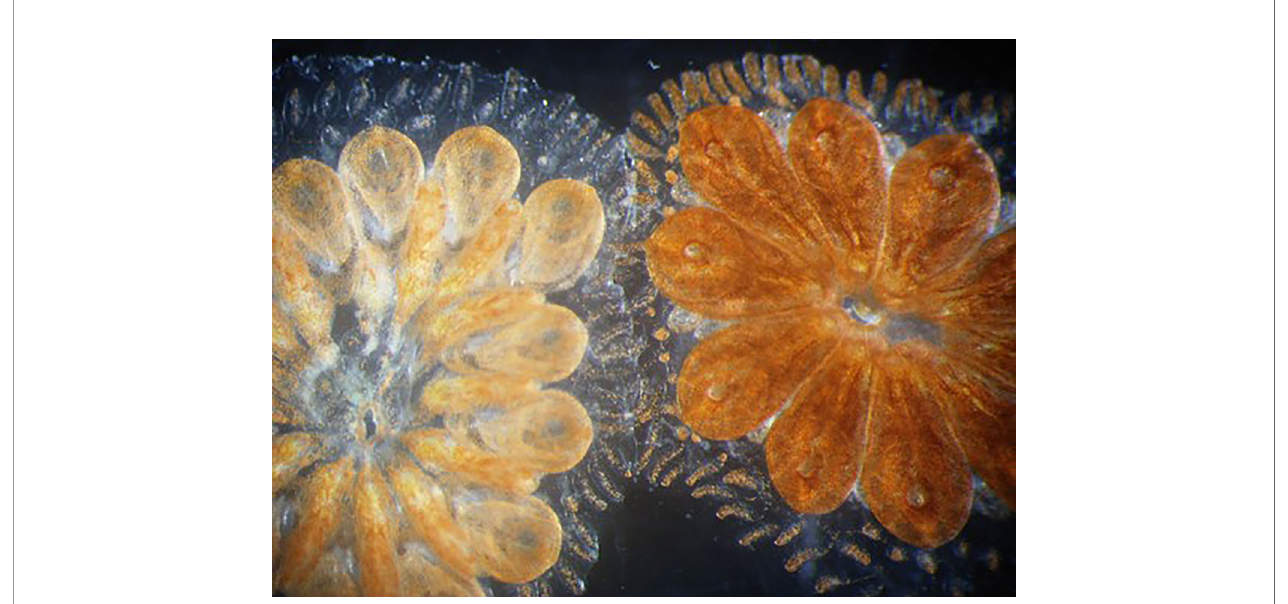
FIGURE 7 | Botryllus chimera. Two genetically compatible colonies fused into a single chimeric colony, sharing the tunic and the circulatory system, after their